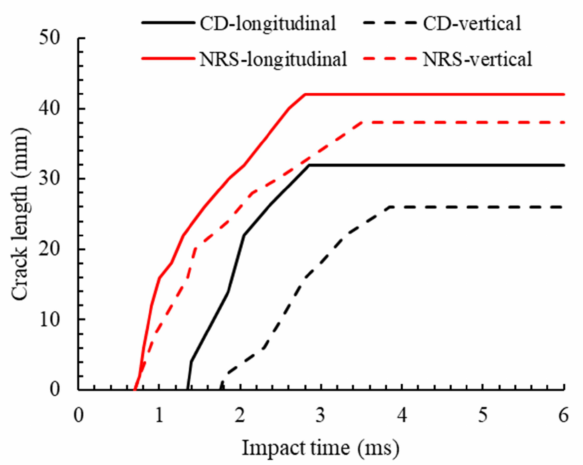
Figure 14. Comparison of the experimental rear side, impact side, and cross-sectional damage morphologies with those from the numerical models: ( a ) NRS and ( b ) CD.